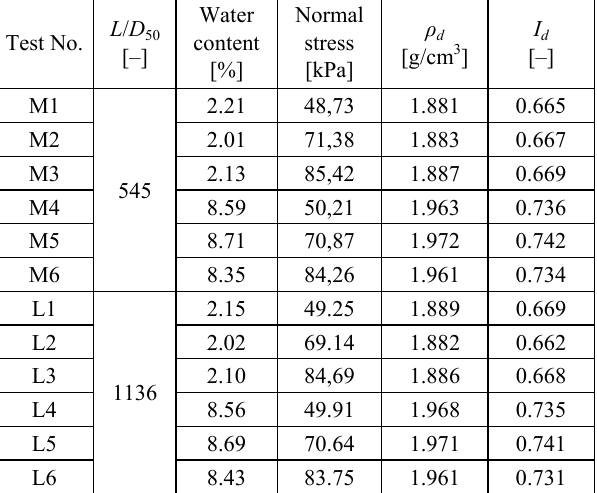
Table 1. Test conditions for RCA direct shear tests Test No.